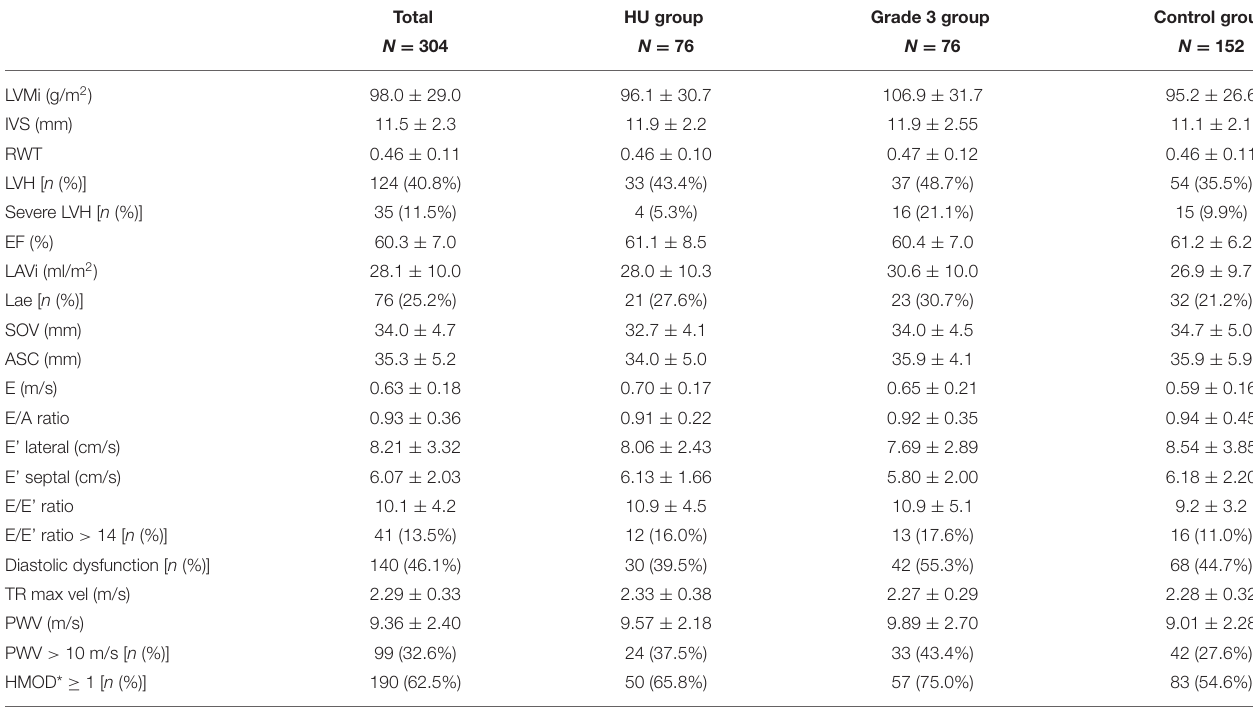
TABLE 1b | Echocardiographic characteristics of total study population and